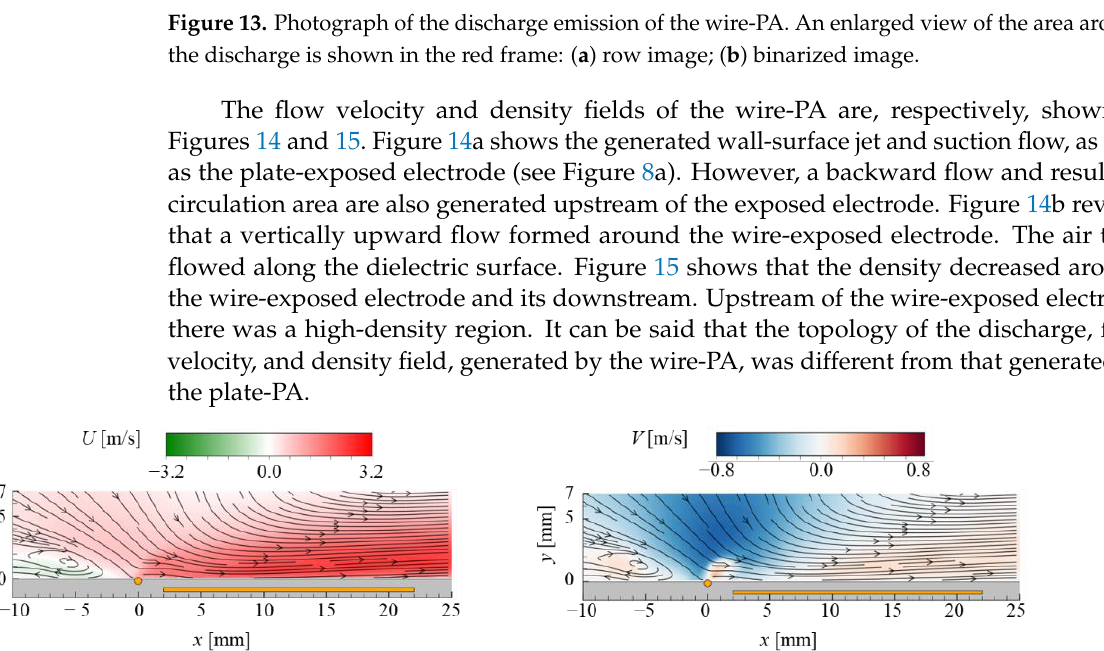
Figure 14. Flow velocity field of the wire-PA, obtained by PIV: ( a ) streamlines and the horizontal velocity; ( b ) streamlines and the vertical velocity.